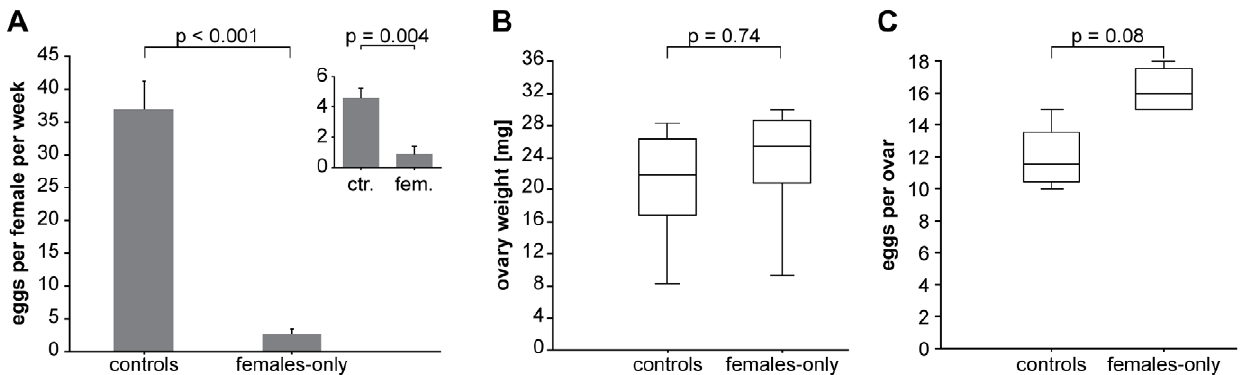
Figure 3. Analysis of reproductive effort. (A) Eggs laid into spawning boxes per female per week were recorded in a female-only (n=12) and a control female cohort (n=6) over 5 weeks beginning at the age of 5 weeks. Presented as inset are eggs laid per female per week when the tank bottom was 100% covered with breeding substrate. (B) At the age of 14 weeks ovaries of 4 females from each group were dissected and weighed. In both groups animals were observed with one ovary of smaller size (controls: 1, females-only: 2). These were included in the analysis. (C) Number of eggs in the ovary was counted in both groups (number of ovaries=4). For this analysis only normal sized ovaries were used. Box plots show median, interquartile range and total range by lines, boxes and whiskers,